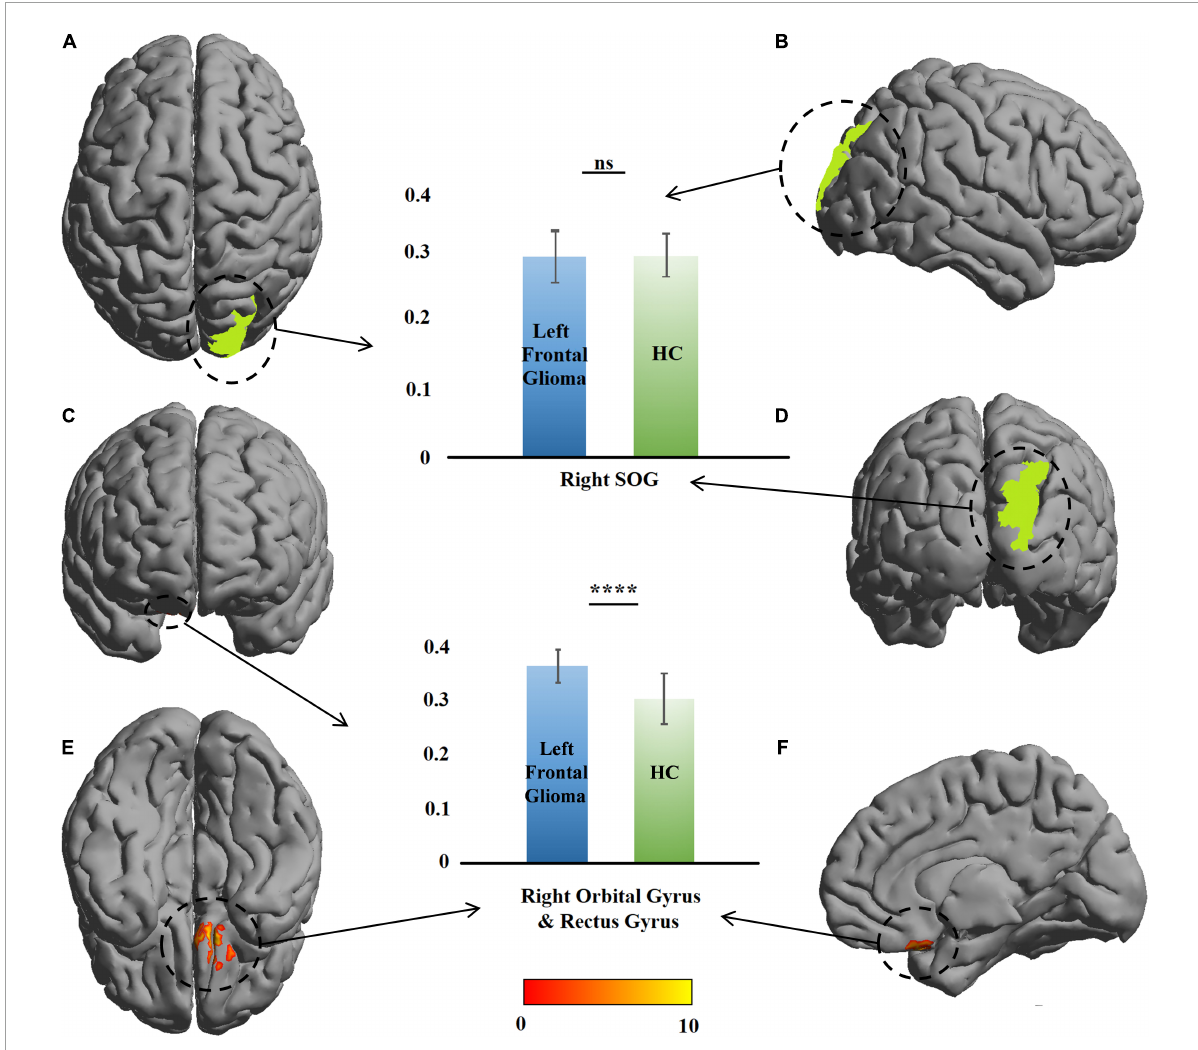
FIGURE2 Comparison of gray-matter volume (GMV) between the patients with left frontal glioma and healthy controls (HCs). The warm colors (red to yellow) indicate the significant area (the right orbital gyrus and gyrus rectus) with the right frontal GM indicated as the mask. Green color indicates the right superior occipital gyrus (SOG). The GMVs of the patients and HCs are presented as histograms. ns, not significant. **** P ≤ 0.0001. (A) Top view; (B) right view; (C) anterior view; (D) posterior view; (E) bottom view; (F) left view (only right cerebral